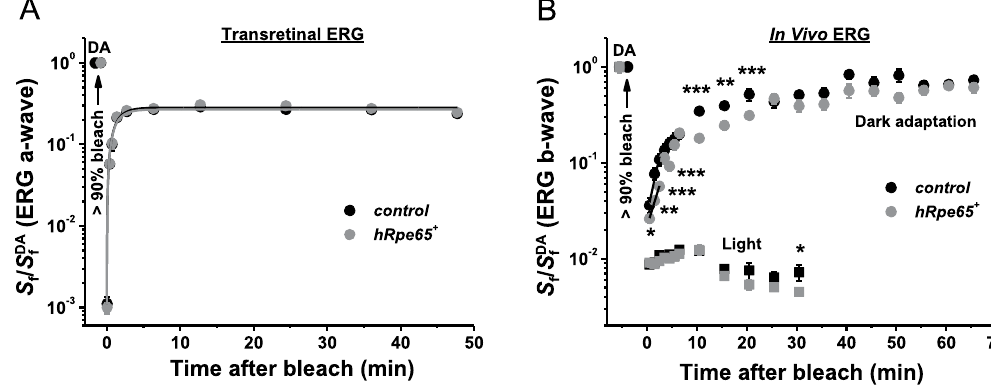
Figure 7. M-cone dark adaptation in transgenic mice expressing human RPE65. ( A ) Recovery of normalized cone a -wave flash sensitivity ( S f ; mean ± SEM) in isolated retinas of control Gnat1 − / − (n = 6) and transgenic Gnat1 − / − hRpe65 + (n = 6) mice after bleaching > 90% of cone pigment at time 0 with 505 nm LED light. Data were fitted with single-exponential functions that yielded time constants of ~1.2 min in both cases. S fDA denotes the sensitivity of dark-adapted cones. ( B ) Recovery of photopic ERG b -wave ( S f ; mean ± SEM, * P < 0.05, ** P < 0.01, *** P < 0.001) in vivo in control Gnat1 − / − (n = 5) and transgenic Gnat1 − / − hRpe65 + (n = 4) mice after bleaching > 90% of cone pigment at time 0 with 520 nm LED light. S f was normalized to the corresponding dark-adapted value ( S fDA ) in each case. Initial rates of S f recovery were determined from linear fits (black lines) that yielded the slopes of 0.24 min − 1 (control) and 0.17 min − 1 (transgenic). Squares show the change of photopic ERG b -wave ( S f ; mean ± SEM, * P < 0.05) in vivo following illumination with green 530 nm Ganzfeld background light (300 cd m − 2 , 30 min) in control (n = 4) and transgenic (n = 4) mice. S f was normalized to the corresponding dark-adapted value ( S fDA ) in each case. Error bars for some points in ( A , B ) are smaller than the symbol